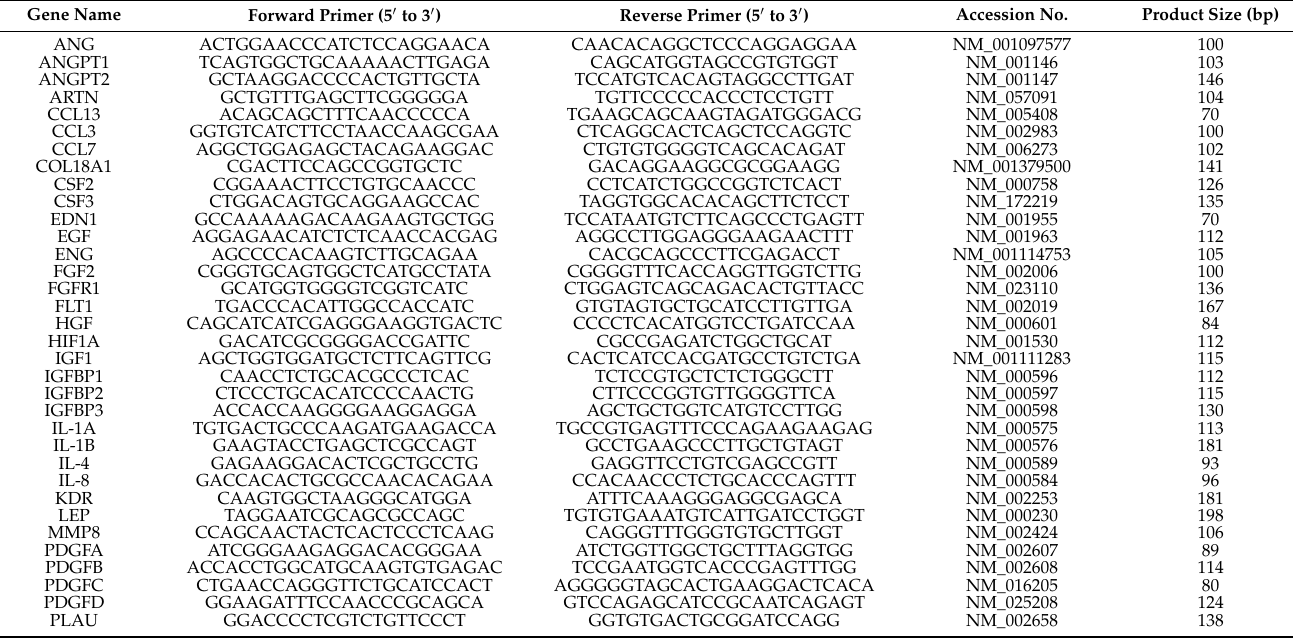
Table 1. Primer pairs for real-time quantitative polymerase chain